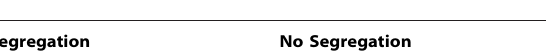
Table 2. Percentage of Jurkat T cells on supported planar bilayers organizing SLP-2-gfp close to pSMAC at the contact